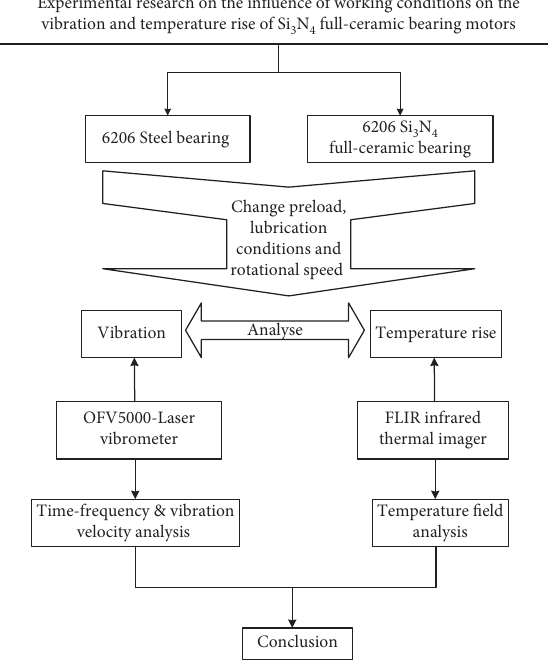
Figure 5: Experimental